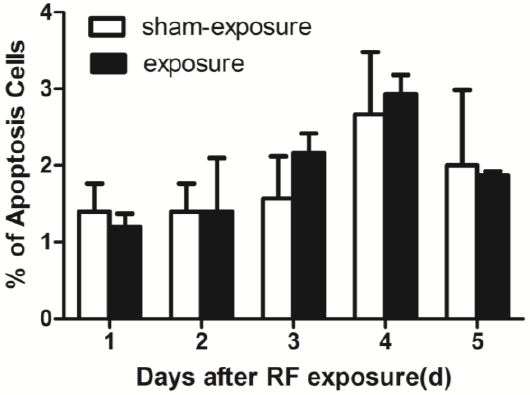
Figure 3. Percentage of apoptosis in TM3 Leydig cells at 1 day to 5 days following exposure to RF-EMR. Values represent mean ± SEM for each of the exposure and sham-exposure groups at each time point.